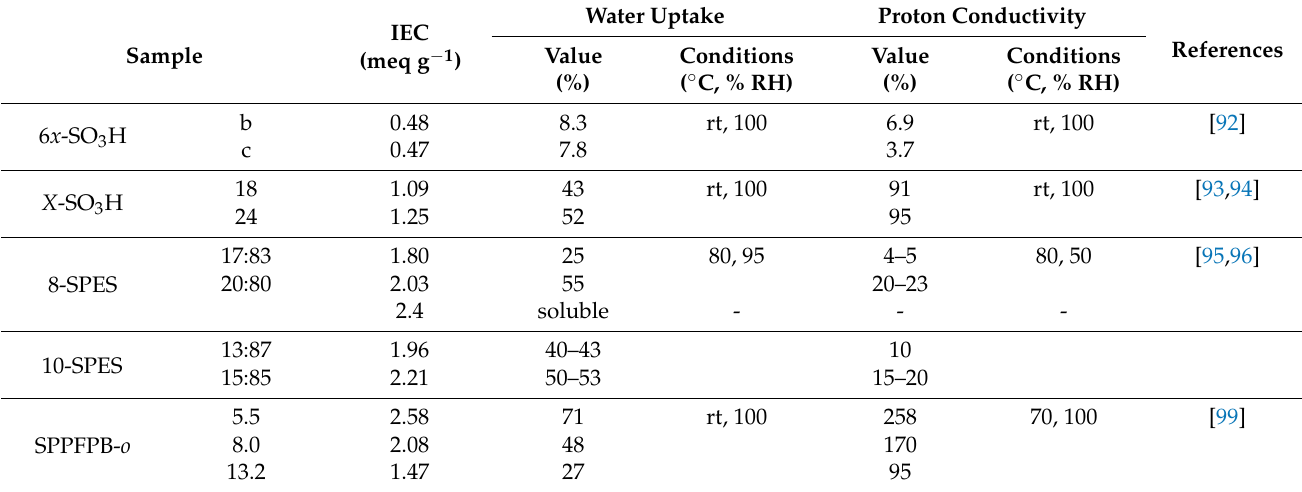
Table 5. Properties of densely sulfonated copolymer-based polymer electrolyte